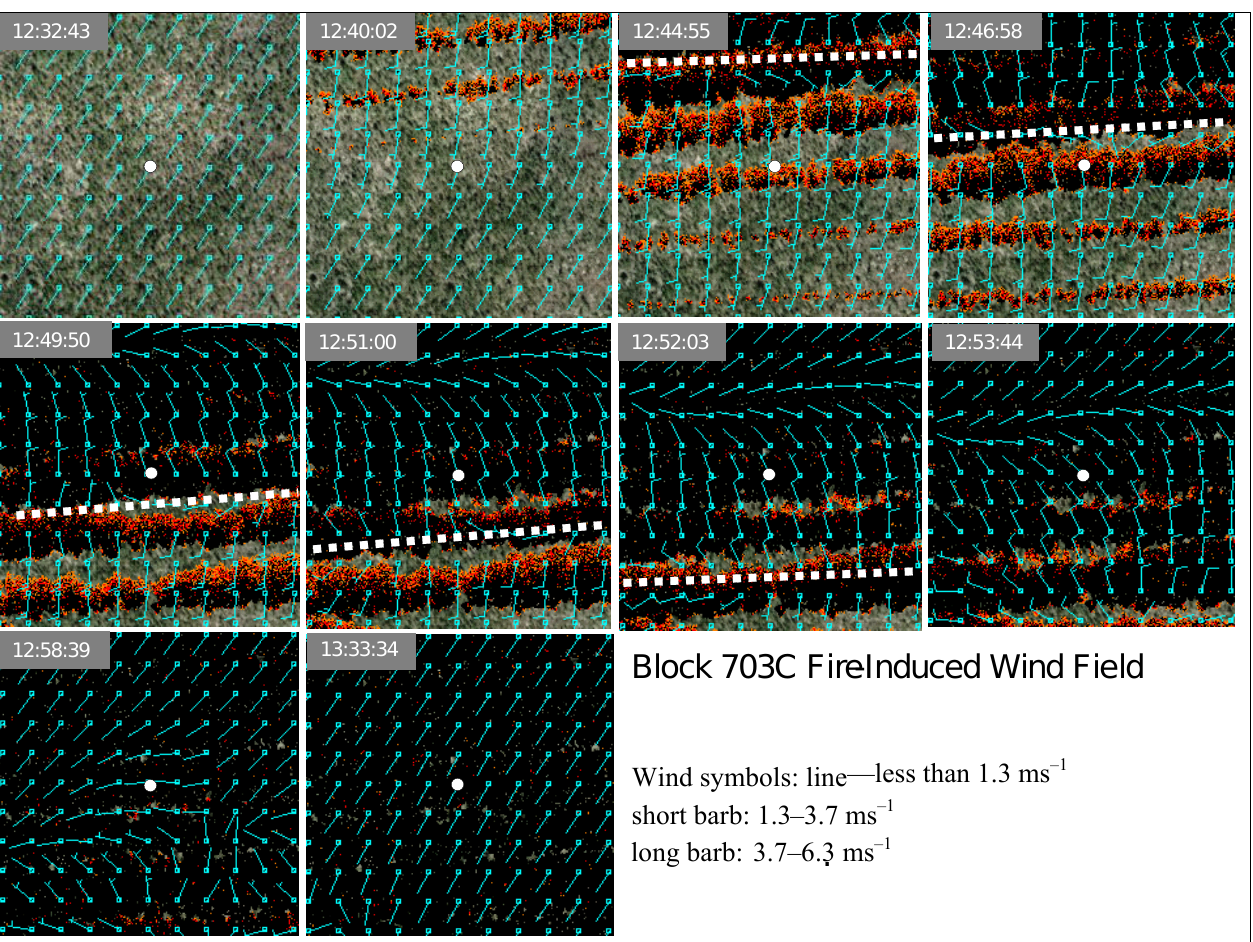
Figure 4. Fire-atmosphere coupling between winds and fire on the landscape within a sub-area of Figure